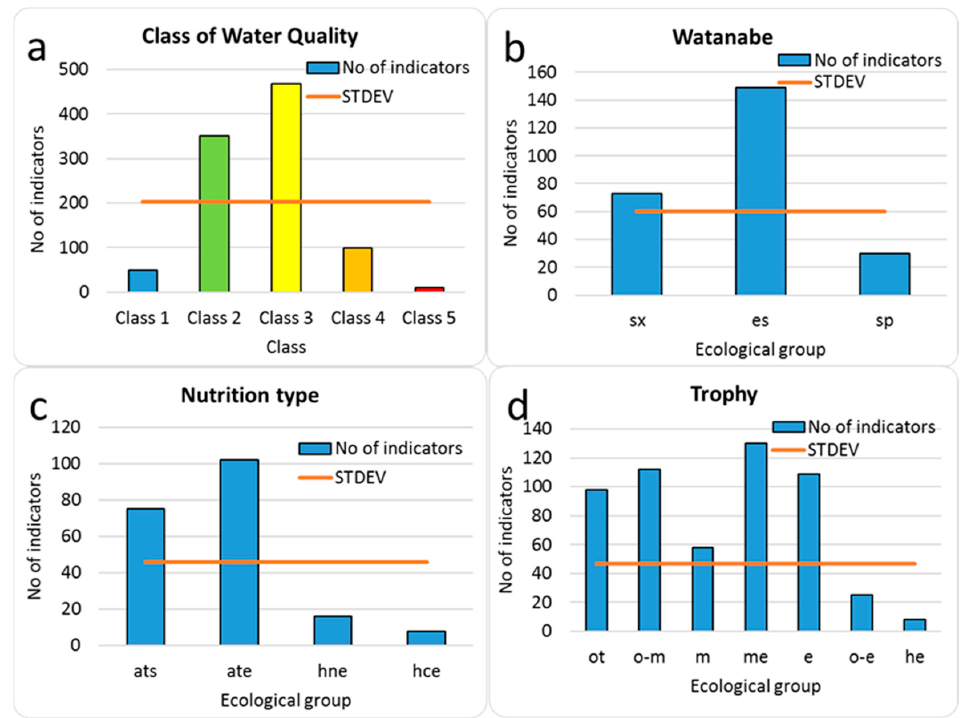
Figure 4. Distribution of species-indicator in groups of preferences of water quality class in the EU FWD color ranges ( a ). Organic pollution according to Watanabe (sx—saproxenes; es—eurysap-